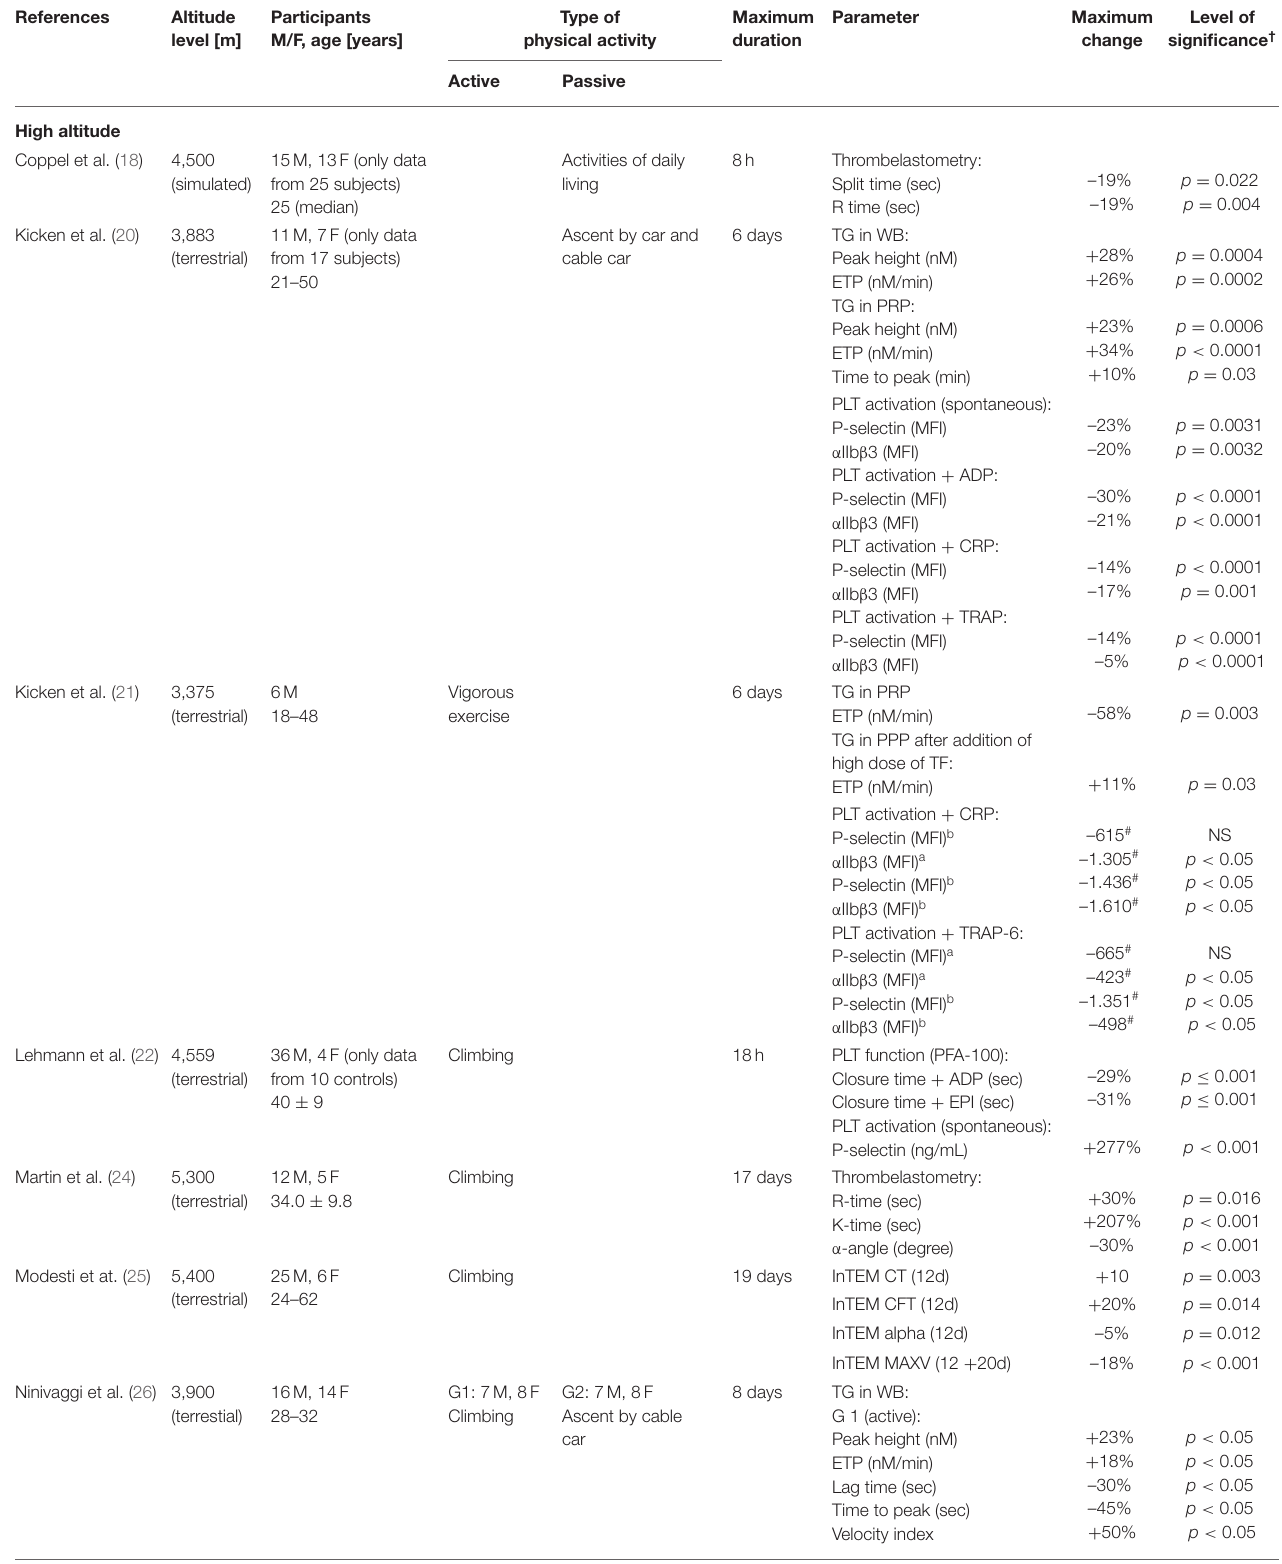
TABLE 4 | Changes of thromboelastometry, thrombin generation and platelet function during exposure to high altitude (ten studies, n =